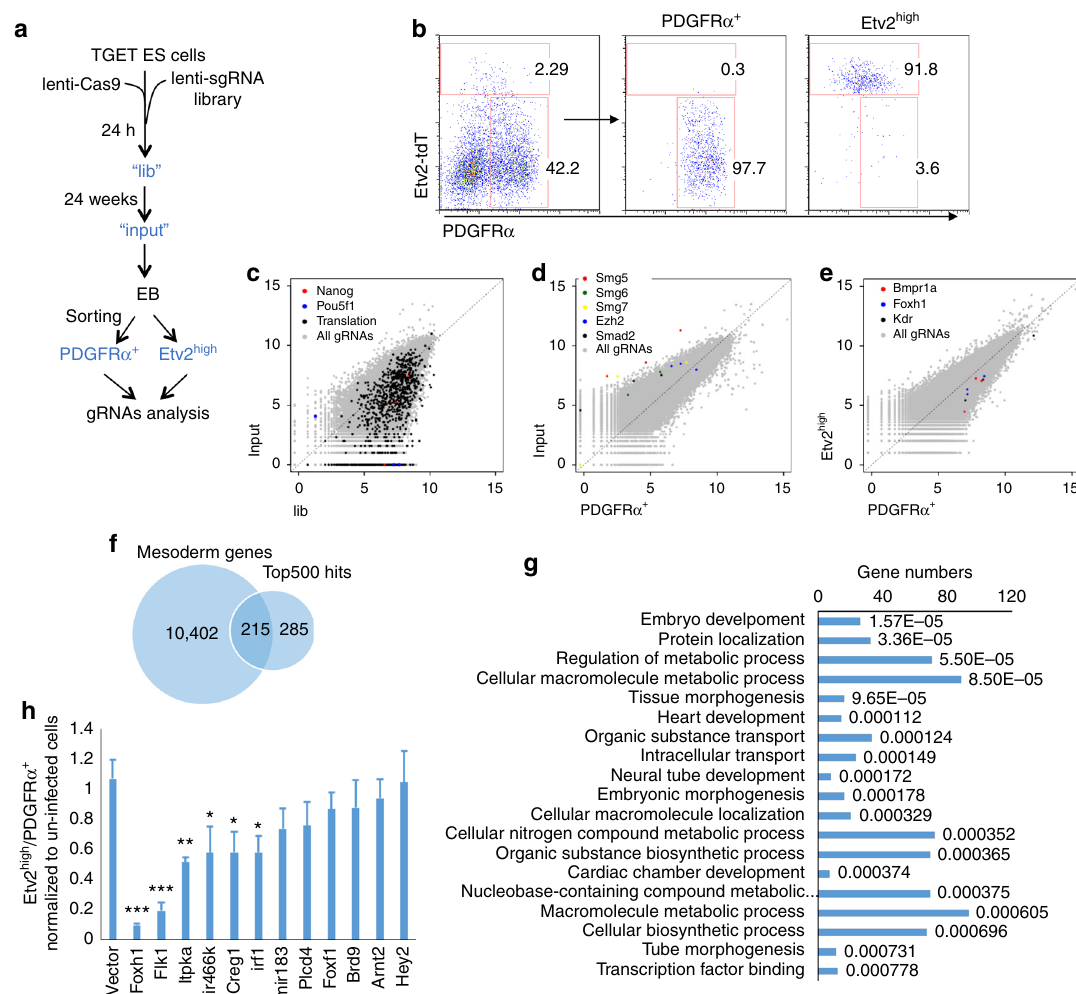
Fig. 3 CRISPR screening identi fi es key Etv2 upstream regulators. a Scheme for CRISPR screening. b FACS plot of the Etv2 high and PDGFR α + cells from D3.5 TGET EB cells used for cell sorting after CRISPR library infection is shown. c Comparative reads analysis between TGET ES cells (24 h post infection, “ lib ” ) and stabilized TGET ES cells (2 weeks selection post infection, “ input ” ), which shows depletion of gRNAs against essential genes for pluripotency in stabilized TGET ES cells. d Comparative reads analysis between stabilized TGET ES cells ( “ input ” ) and PDGFR α + cells, which shows depletion of